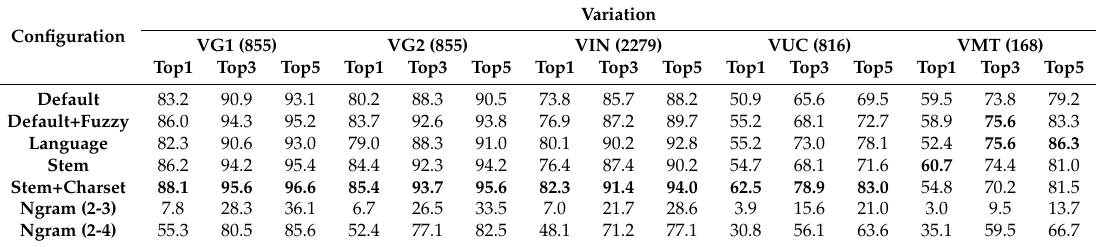
Table 4. Proportion of variations of different types correctly matched with original FAQs (Top1), in Top-3 and in Top-5 most similar, using different configurations of